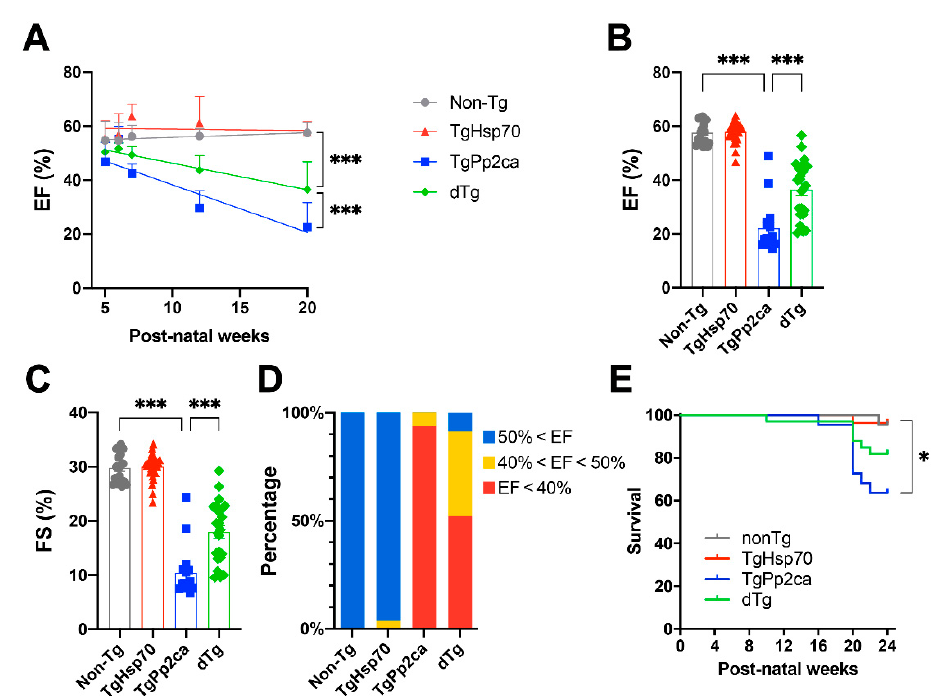
Figure 1. HSP70 alleviated PP2CA-induced cardiac dysfunction and subsequent death. ( A ) The serial changes in the ejection fraction (EF) of transgenic mice were measured. Note that the abrupt decrease in EF was significantly improved in double transgenic mice expressing both HSP70 and PP2CA (dTg). ( B , C ) Cardiac function of individual mice was measured at 20 weeks postnatal using echocardiography. Both EF ( B ) and fractional shortening (FS) were dramatically reduced in TgPP2CA mice (blue squares), whereas these decreases in contractile function were retarded in dTg mice (green rotated squares). ( D ) Heart failure caused by PP2CA was improved in HSP70-expressing mice. The EF of many TgPP2CA mice was below 40%, which indicates systolic heart failure. In contrast, the proportion of mice with heart failure was markedly reduced among dTg mice. ( A – D ) Every dot indicates a single mouse. Cohort size, nTg: 18, TgHSP70: 27, TgPP2CA: 16, dTg: 23. ( E ) Kaplan–Meier survival curves of transgenic mice. During the 6-month cohort study, sudden death of the TgPP2CA mice was observed after 15 weeks, which was correlated with the deterioration of cardiac function, as shown in ( A ). Survival was significantly better in dTg mice than in TgPP2CA mice by Mantel–Cox rank test. Cohort size, nTg: 22, TgHSP70: 27, TgPP2CA: 22, dTg: 33. One-way analysis of variance (ANOVA) with LSD post hoc testing was applied to confirm the significance of differences in panels ( A – C ). A single asterisk * indicates p < 0.05; *** indicates p < 0.001.